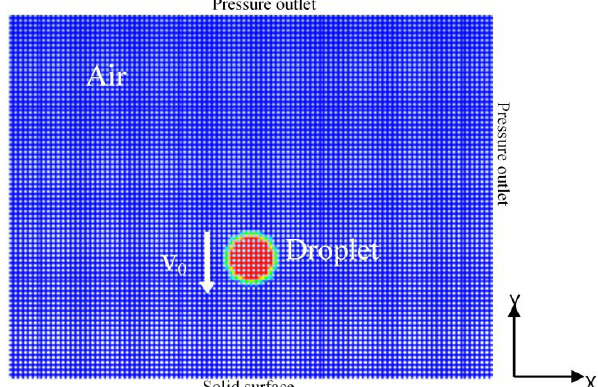
Figure 2. The grid of computational domain and boundary conditions.